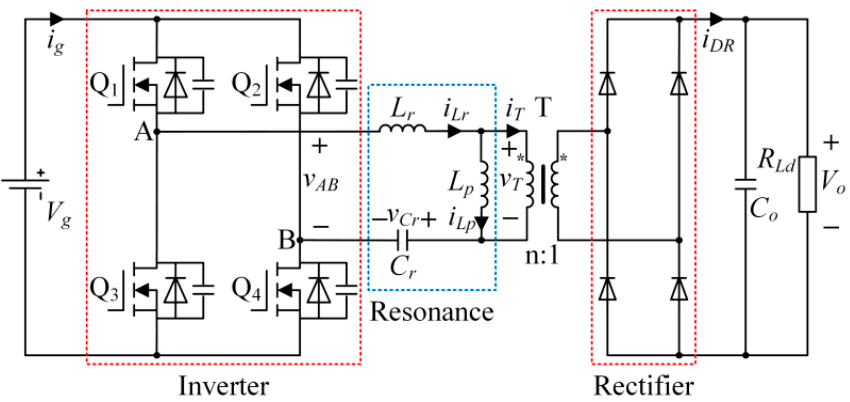
Figure 4. Topology of Full-Bridge LLC Resonant Converter.